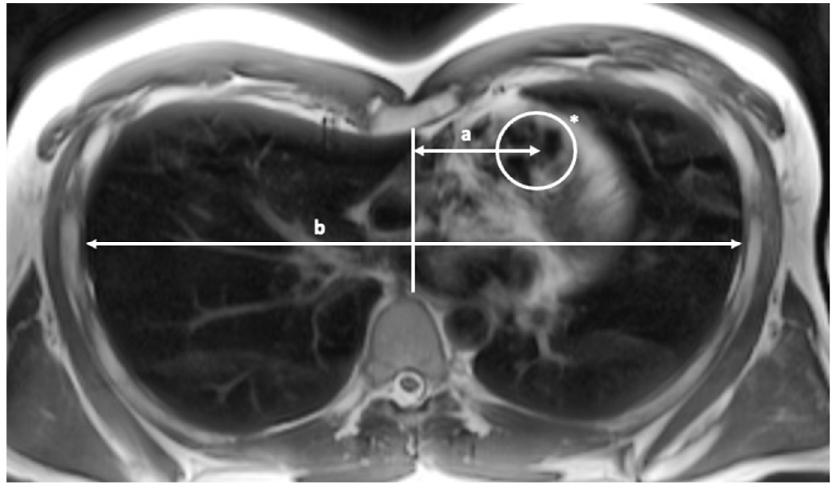
Figure 2. Indexed pulmonary valve position. * = marked the pulmonary valve ring. The lateral position of the pulmonary valve (a) measured from the midline (sterno- spinal line) to the middle of the pulmonary valve and the inner thoracic diameter at the same level (b). Haller Index and Correction Index were calculated in standard fashion (Sectra Imaging Software Version